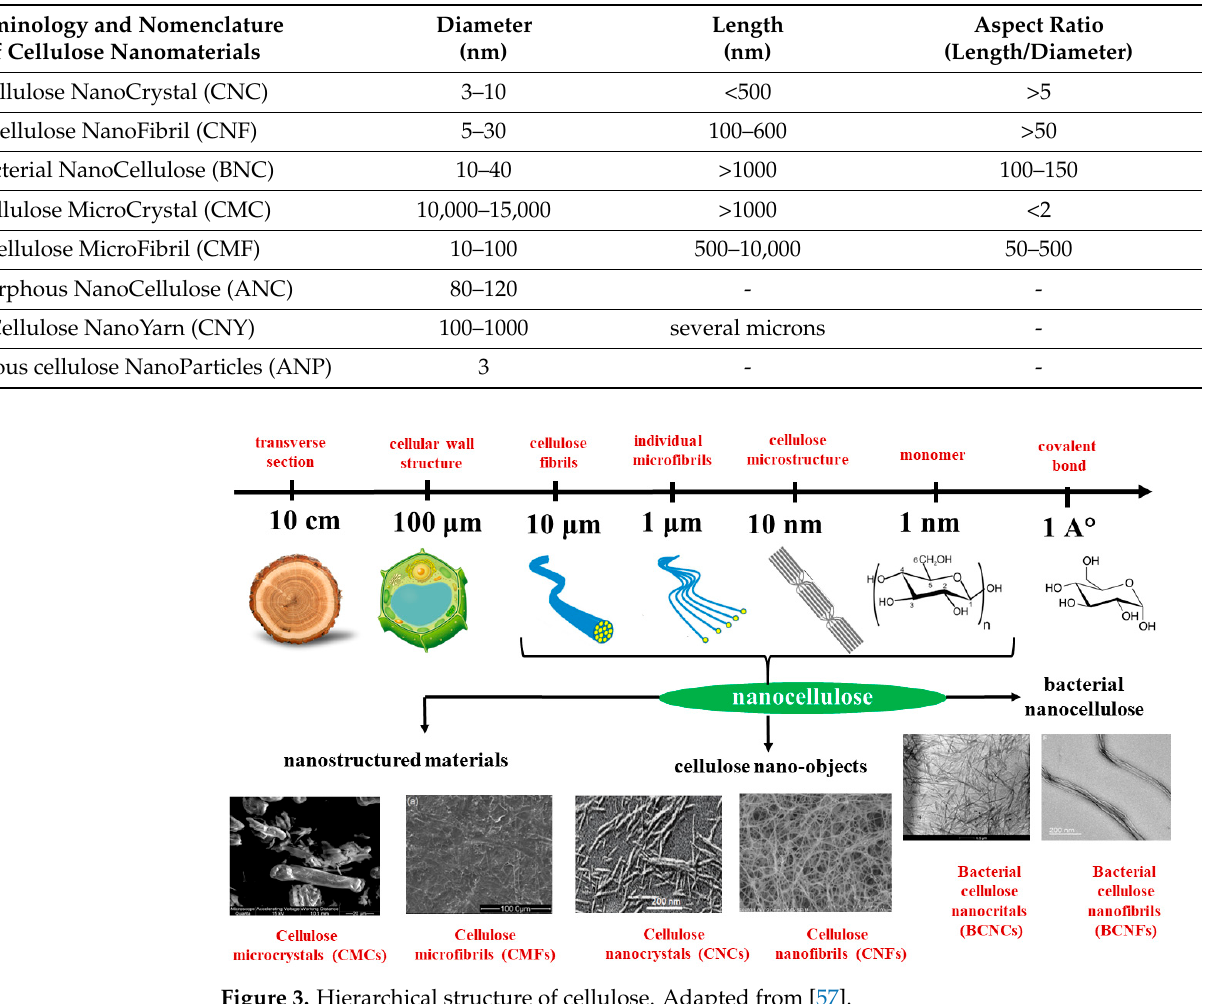
Figure 3. Hierarchical structure of cellulose. Adapted from [57].